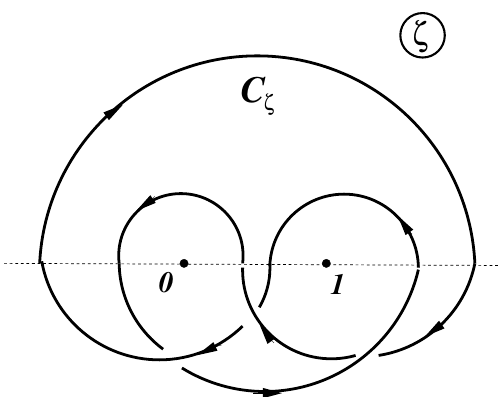
Figure 5 . The Pochhammer loop C ζ appearing in